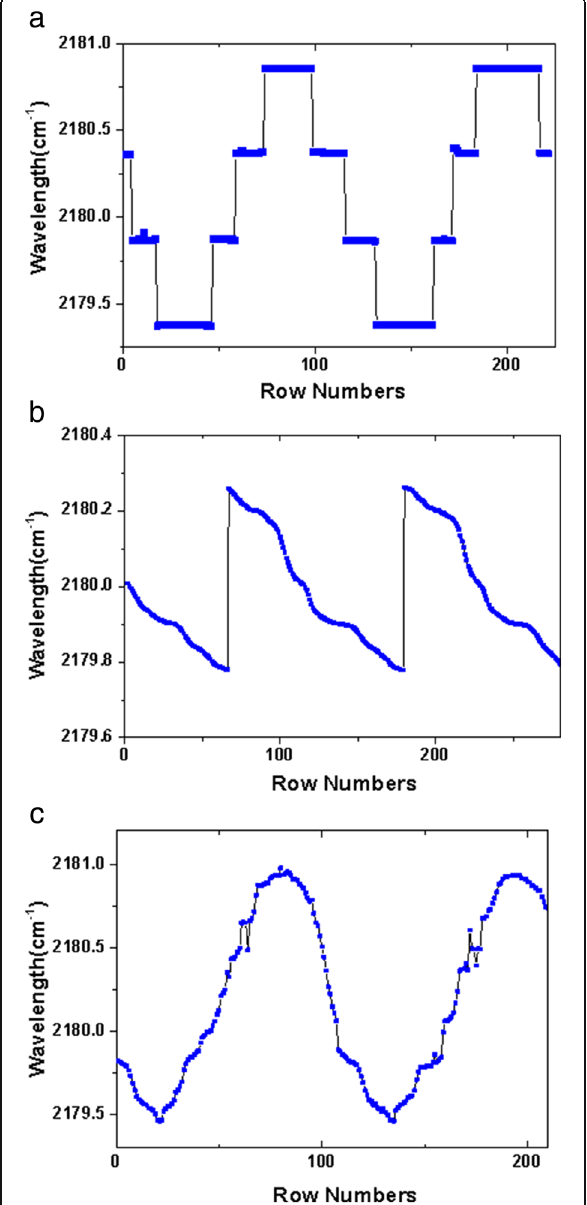
Fig. 5 a The measured EC-QCL wavelength with the galvanometer voltage of 20 mV and the tuning frequency of 0.02 Hz. The mode hop is about 0.5 cm − 1 . b The measured EC-QCL wavelength tuning with a sawtooth wave modulation (0.02 Hz, 40 mA), which can compensate for the 0.5 cm − 1 mode hop. c The measured EC-QCL wavelength with both galvanometer tuning and sawtooth wave